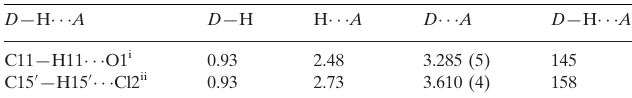
Hydrogen-bond geometry (A˚ , (cid:2)